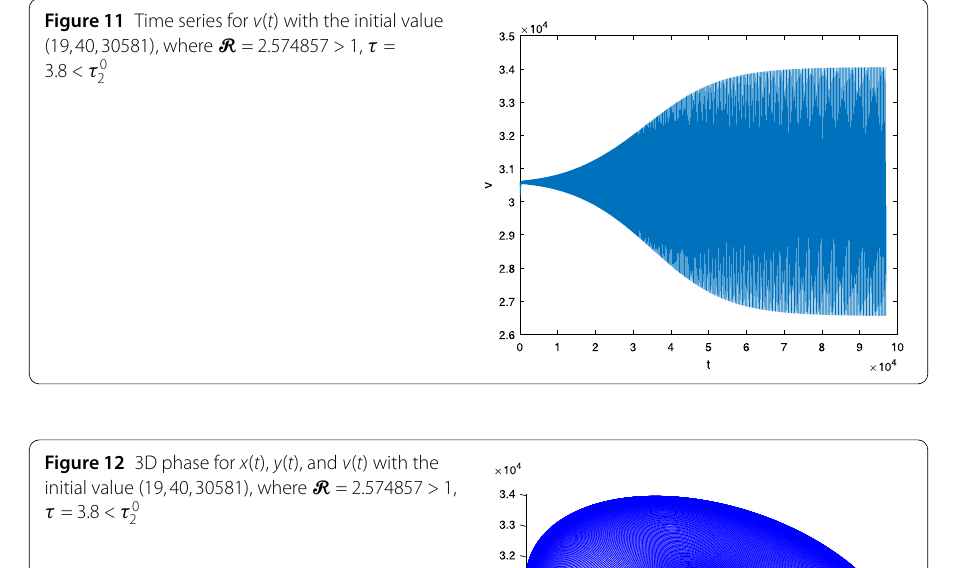
Figure 12 3D phase for x ( t ), y ( t ), and v ( t ) with the initial value (19,40,30581), where R = 2.574857 > 1, τ = 3.8 < τ 0 2